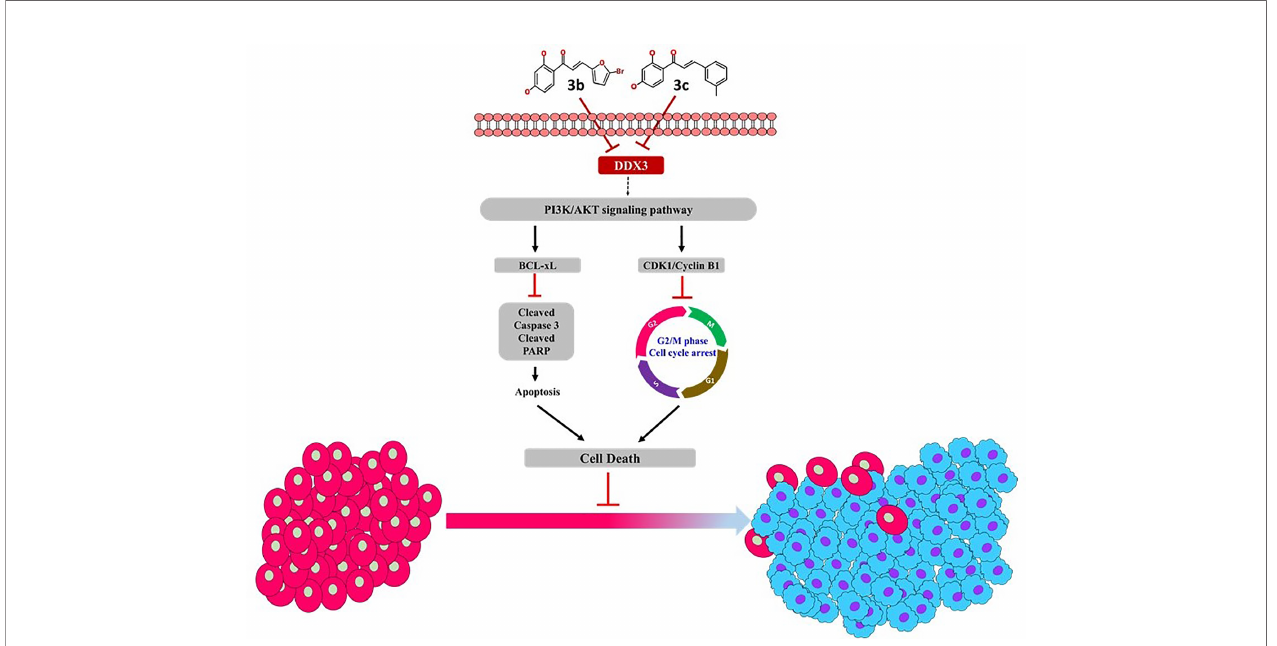
FIGURE 7 | Proposed mechanism of 3b and 3c